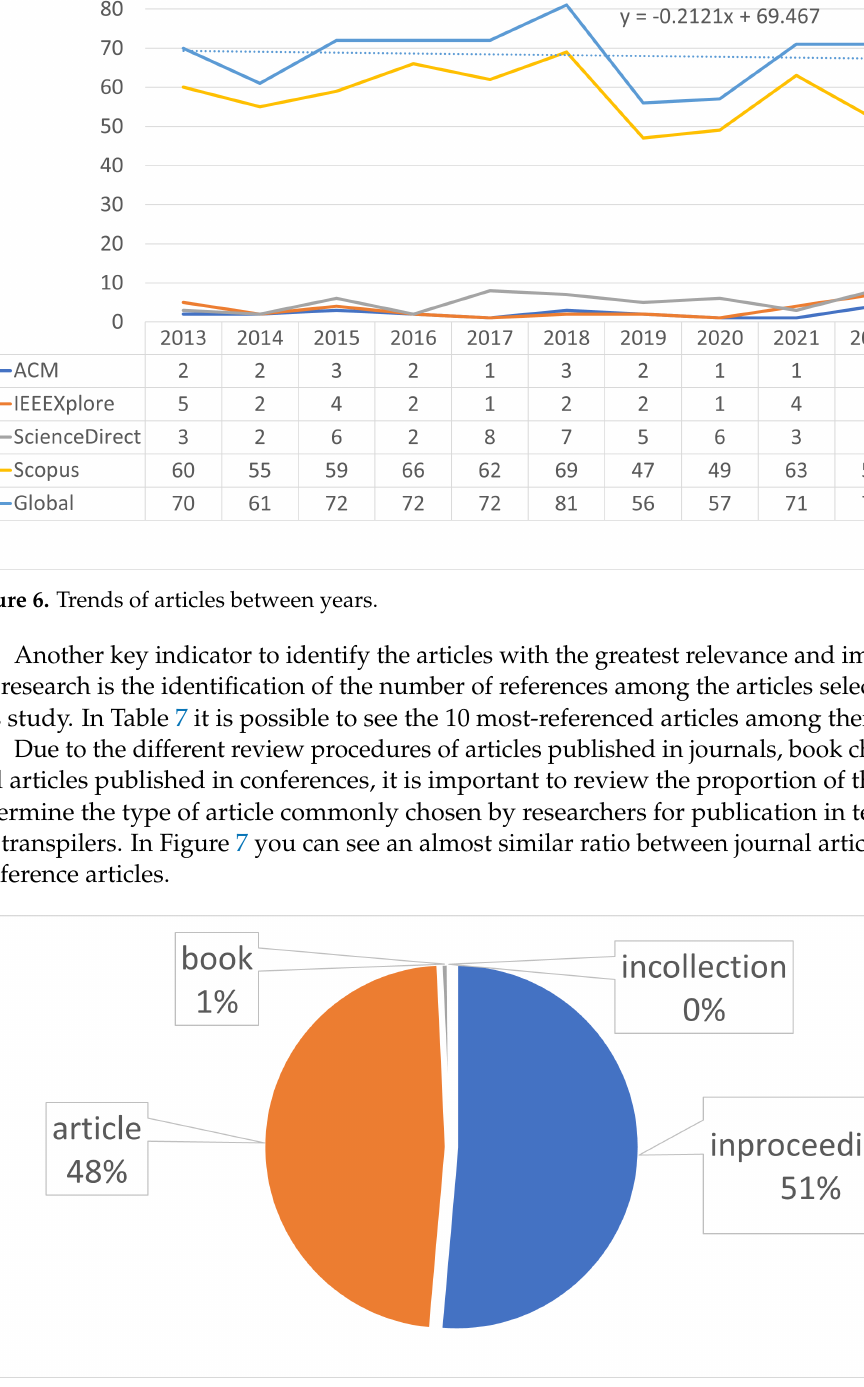
Figure 7. Articles per